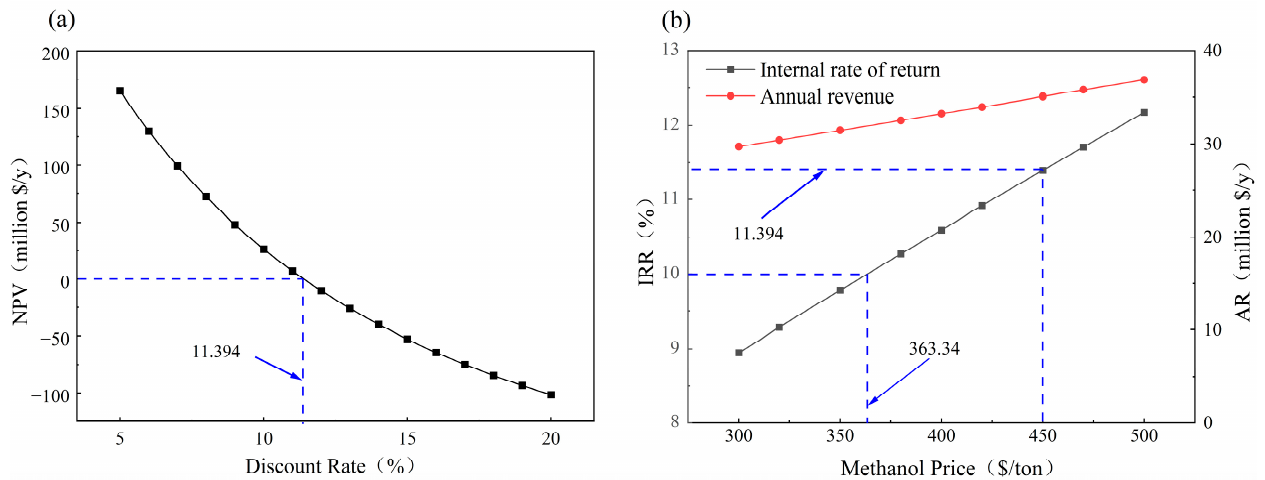
Figure 9. ( a ) The effect of discount rate on the NPV of the project in 20 years life span; ( b ) Impact of methanol prices on the final IRR and AR of the project.